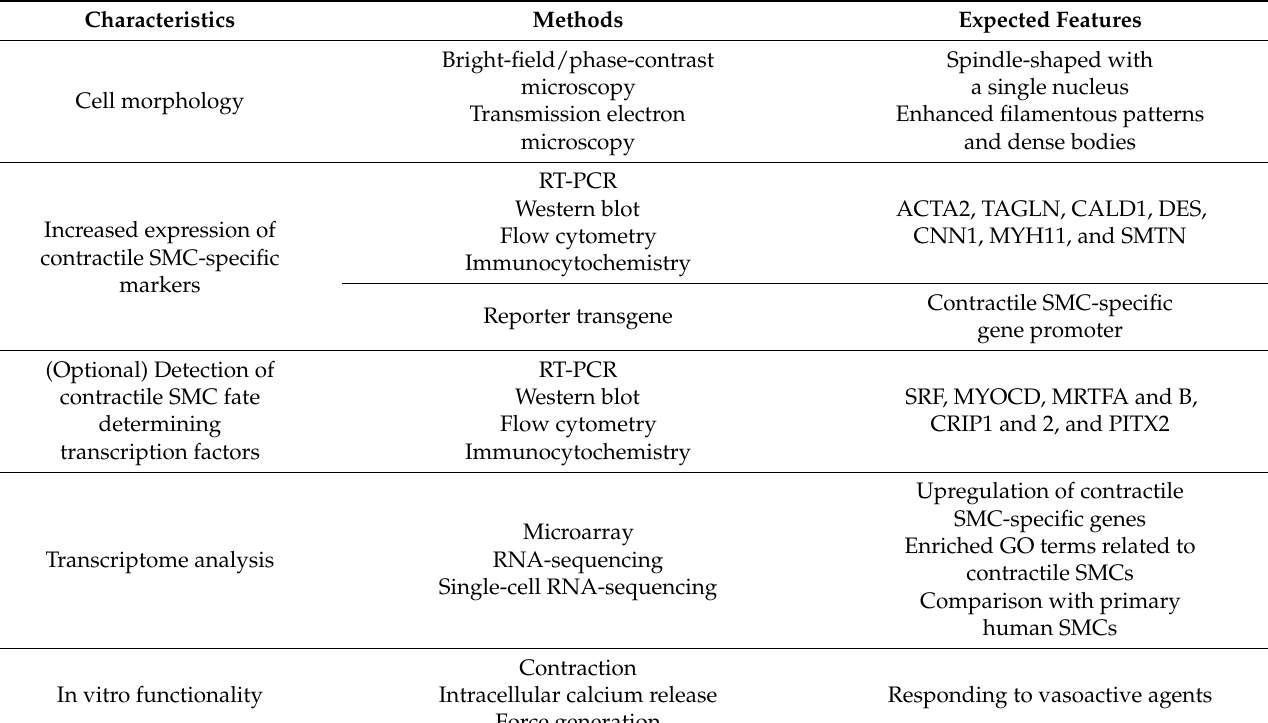
Table 2. Criteria to define contractile SMC